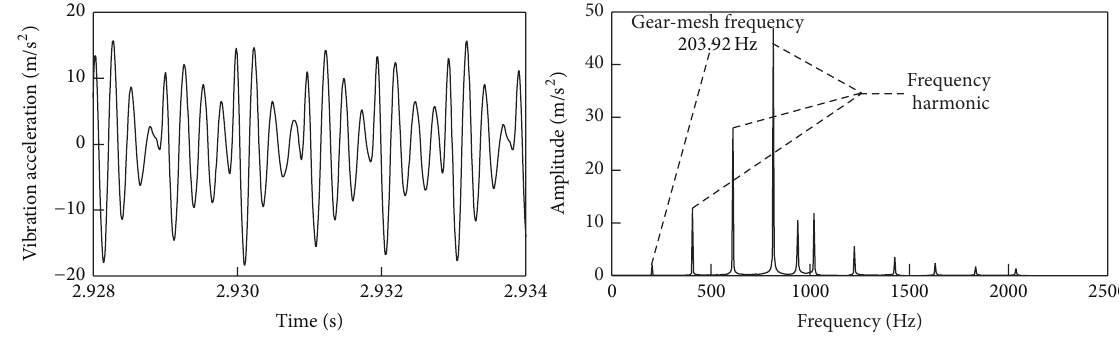
Figure 11: II-stage time-history vibration acceleration and FFT